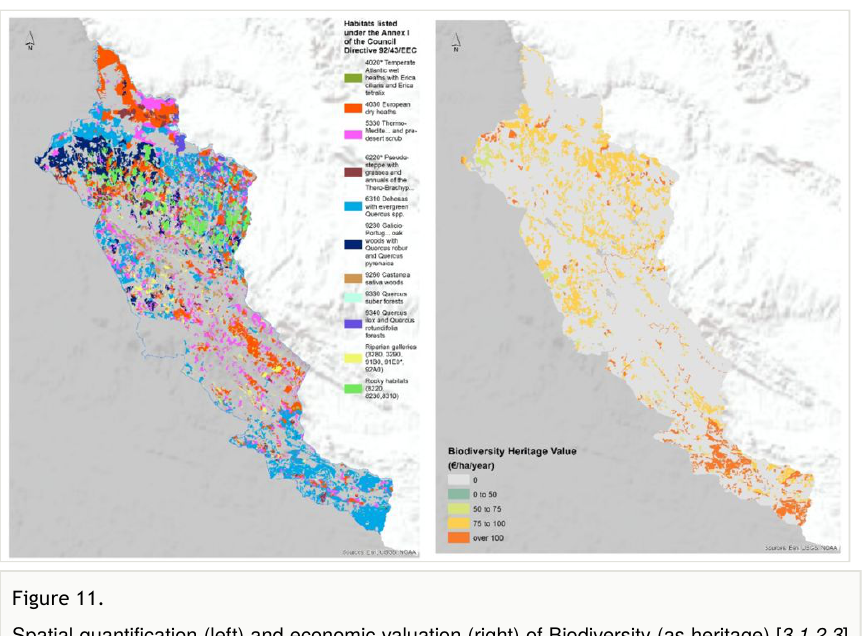
Figure 11. Spatial quanti fi cation (left) and economic valuation (right) of Biodiversity (as heritage) [ 3.1.2.3 ] within